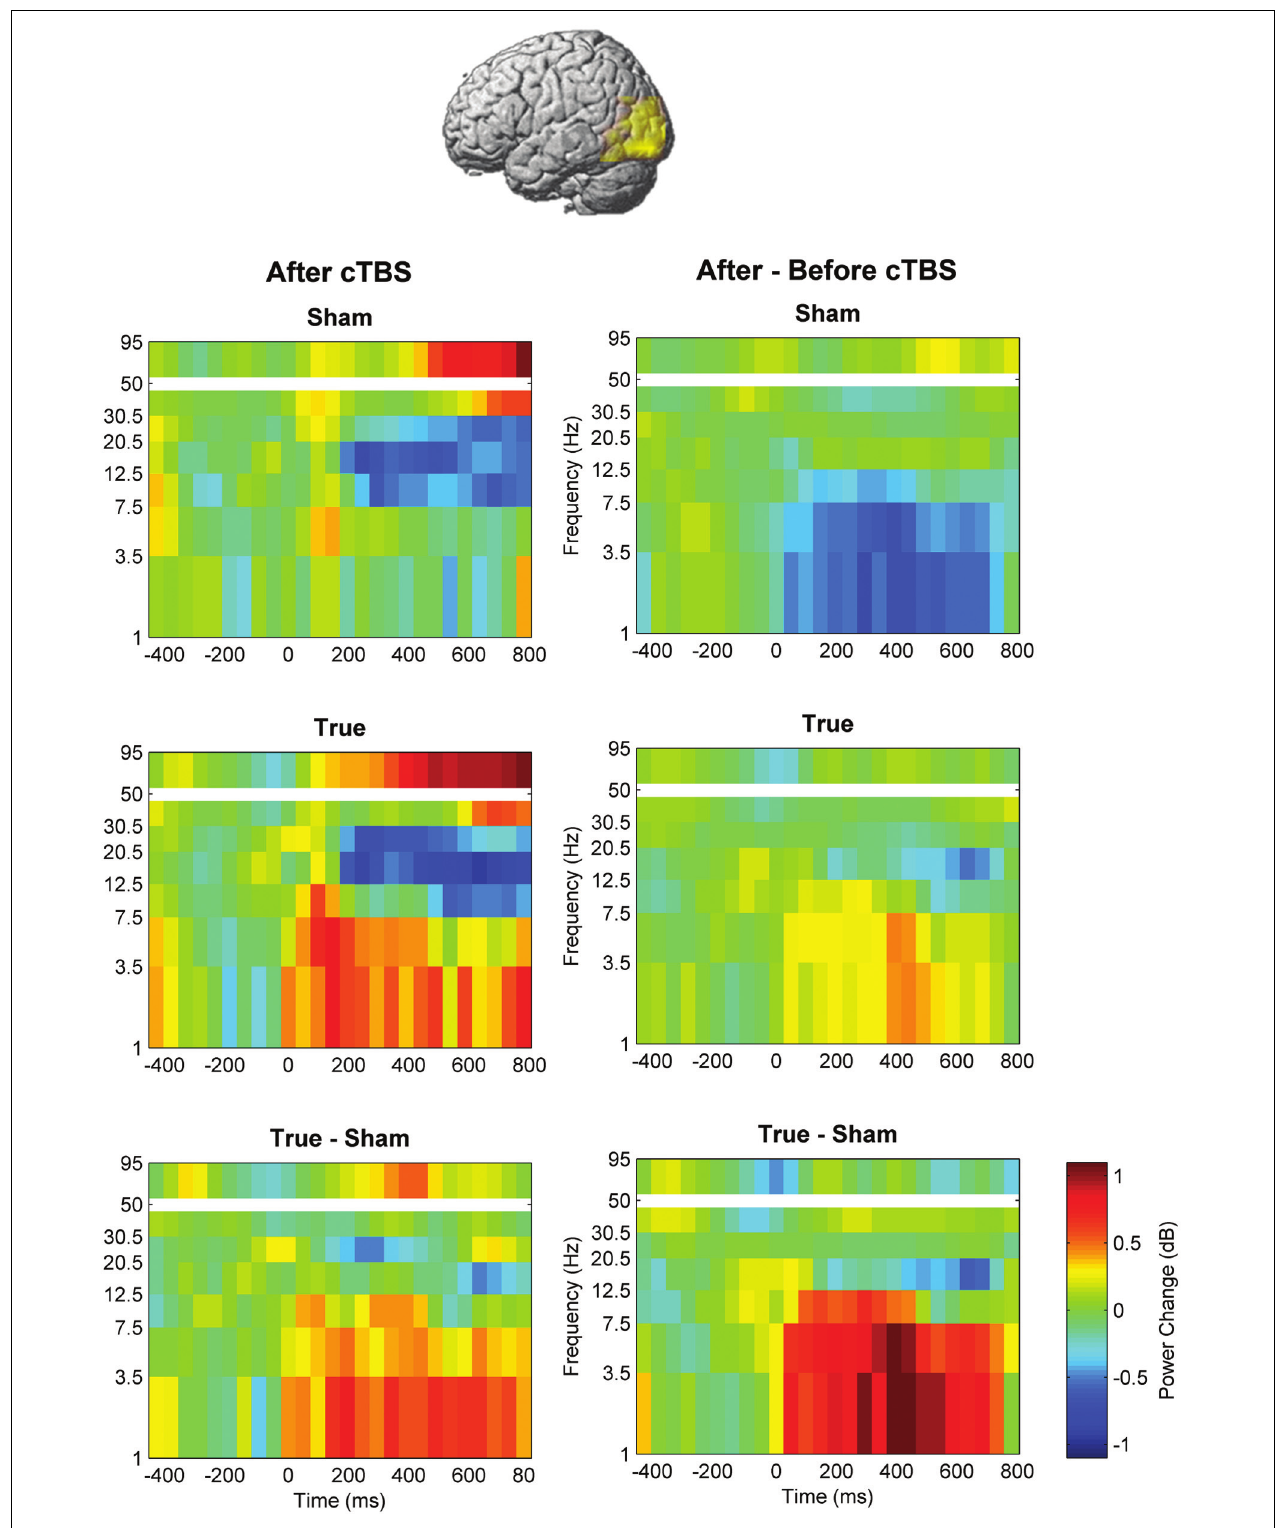
FIGURE 5 | Comparison of induced brain responses over the left temporo-occipital region. The panels in the left column show naming-related power changes 1 day after stimulation, whereas the right-hand panels represent the difference (after minus before). Significant power increase at low frequencies was observed after cTBS in comparison to